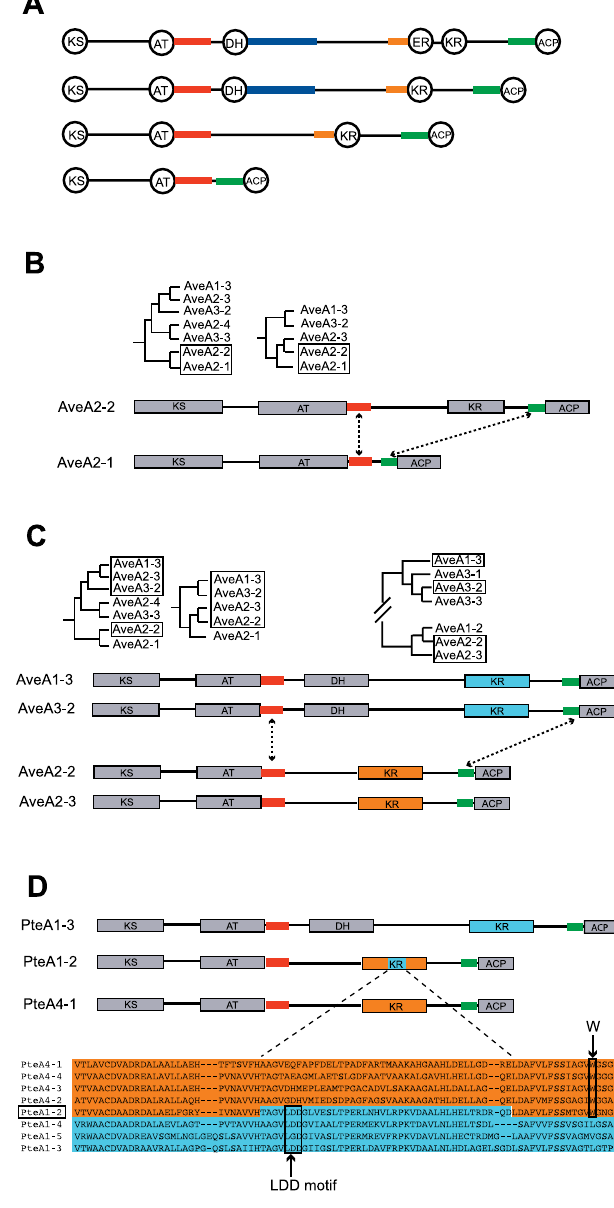
Figure 6. Reduction Level Changes by Recombinatorial Sequence Replacements (A) Homologous sequence stretches in the interdomain linkers of the different module types. (B) Loss or gain of a KR domain. (C) Exchange of a DH–KR domain unit. (D) Creation of a mixed KR domain type by recombination. Partial amino acid sequences are depicted in blue and orange to show the hybrid character of the PteA1–2 KR domain. DOI: 10.1371/journal.pcbi.0020132.g006